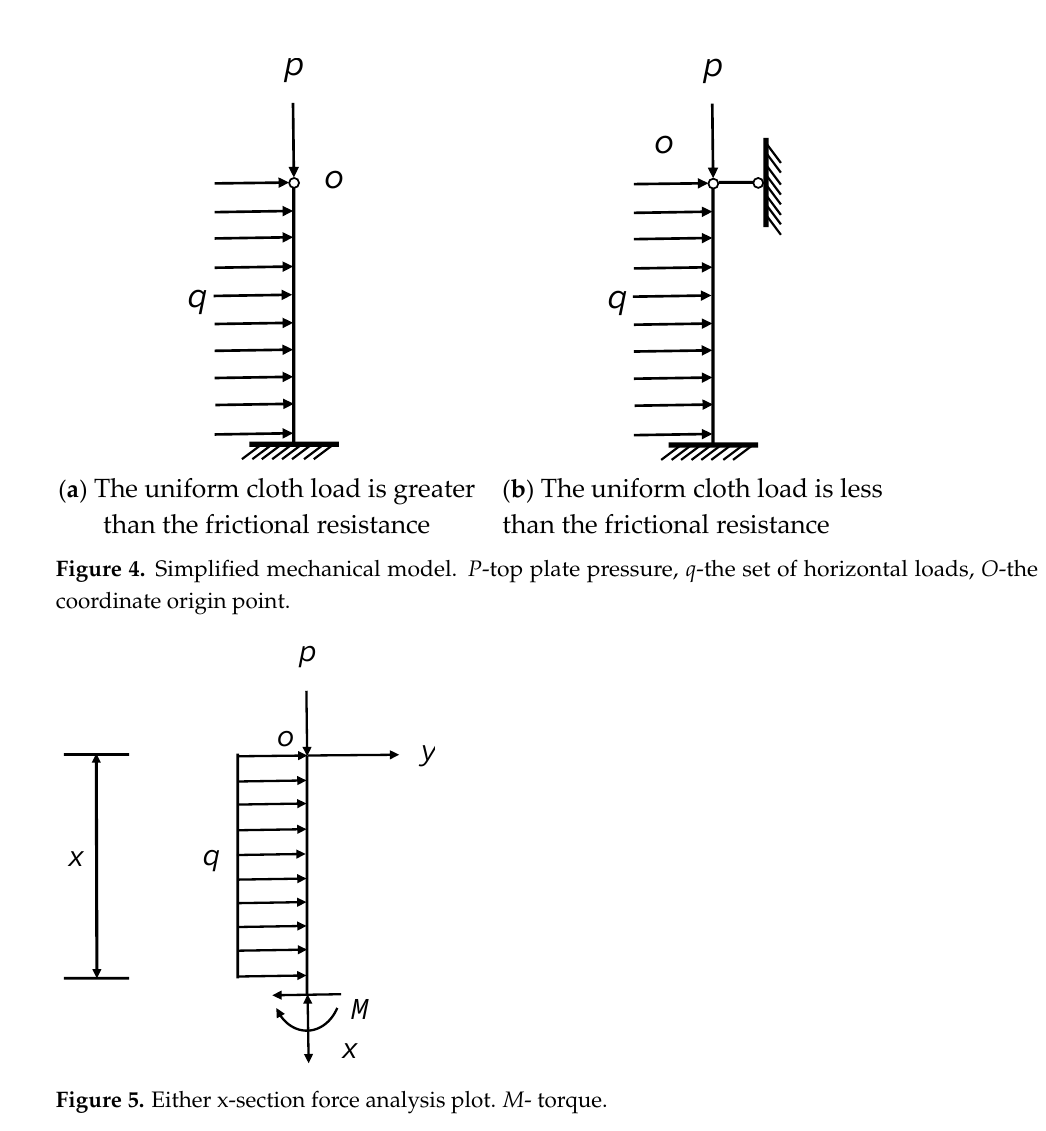
Figure 5. Either x-section force analysis plot. M - torque.